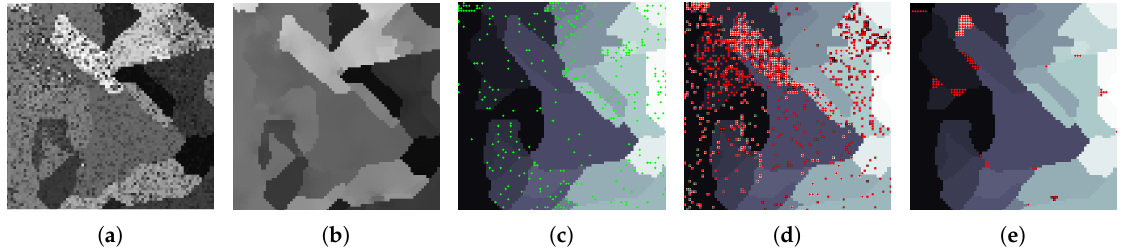
Figure 10. ( a ) 13th band of a highly spectrally mixed synthetic 64-band image. ( b ) 13th band of the ECAS-II output ( c ) Ground truth (green points represent training samples), ( d ) Classification produced using the SVM by itself (red points represent misclassified pixels), ( e ) Classification produced by ECAS-II +